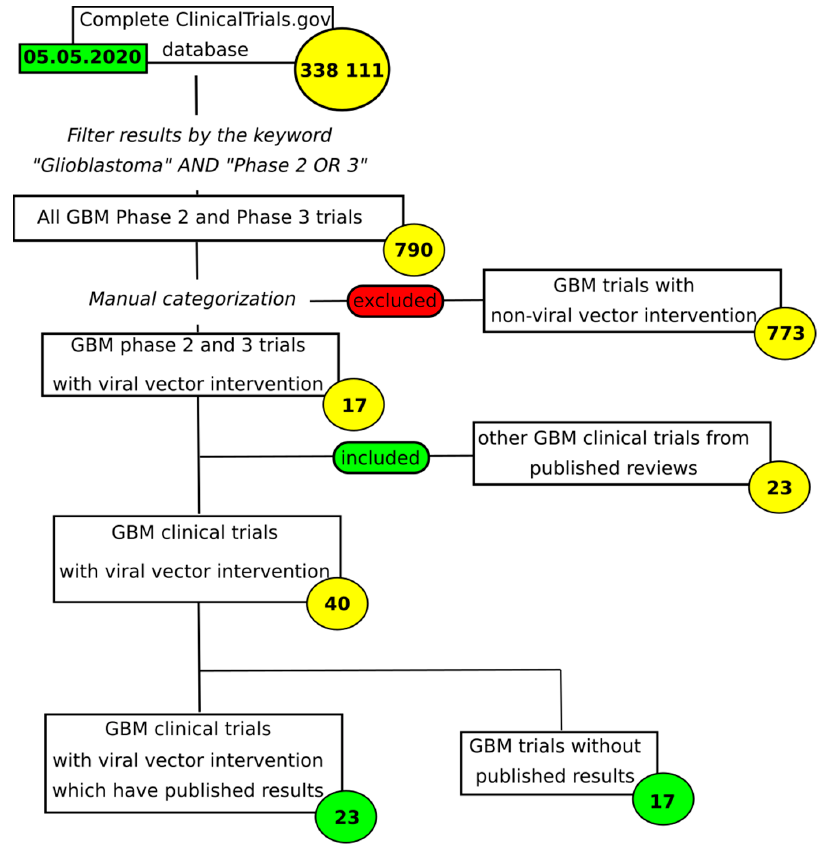
Figure 1. Selection and inclusion criteria for review of glioblastoma multiforme (GBM)-targeting viral vector trials. Table 1. Comparison of key features of viral vectors proposed for treatment of GBM.